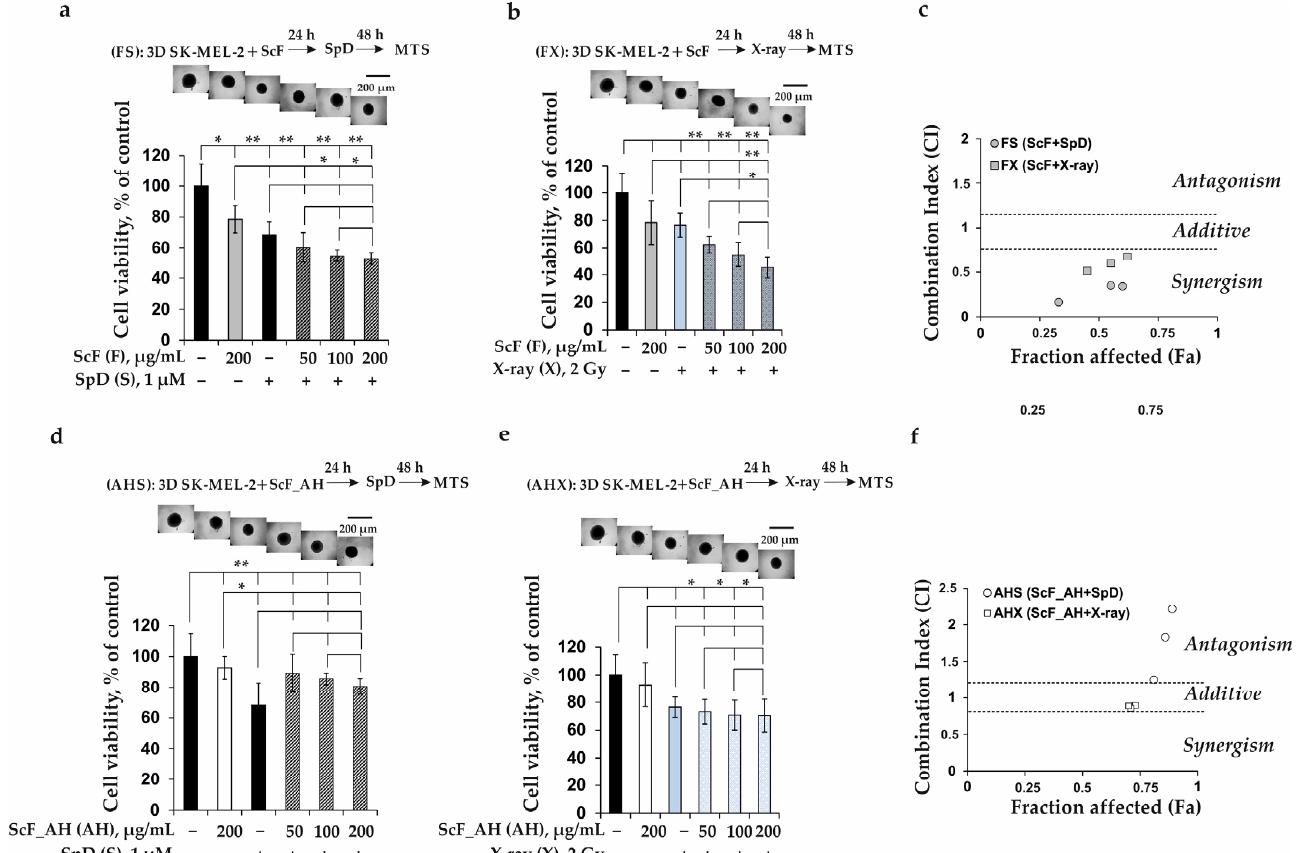
Figure 3. Two-component combined effect of fucoidan from S. cichorioides (ScF) with pacificusoside D from S. pacificus (SpD) or X-ray and the product of autohydrolysis of fucoidan ScF_AH (AH) with SpD (D) or X-ray on the viability of 3D human melanoma cells SK-MEL-2. SK-MEL-2 spheroids were treated by ( a ) ScF (50, 100, and 200 µg/mL) in combination with SpD (1 µM) (FS combination); ( b ) ScF (50, 100, and 200 µg/mL) in combination with X-ray (FX combination); ( d ) ScF_AH (50, 100, and 200 µg/mL) in combination with SpD (1 µM) (AHS combination); ( e ) ScF_AH (50, 100, and 200 µg/mL) in combination with X-ray (AHX combination) for total 72 h. The cell viability was estimated using MTS assay. Photographs ( n = 6, where n = number of photographs) of each spheroid were taken using the ZOE™ Fluorescent Cell Imager. Data show the mean of three independent experiments ± SD. A one-way ANOVA and Tukey’s HSD test for multiple comparisons indicated the statistical significance (* p < 0.05 and ** p < 0.01). ( c , f ) Type of combined action of FS, FX, AHS, and AHX combinations calculated using Compusyn 1.0.1 software (ComboSyn, Inc., USA). The combined index (CI) is a quantitative measure of the degree of interaction between test compounds. CI equal to 0.9–1.1 is considered additive; a CI value greater than 1.1 represents antagonism; and CI values less than 0.7 indicate synergism.